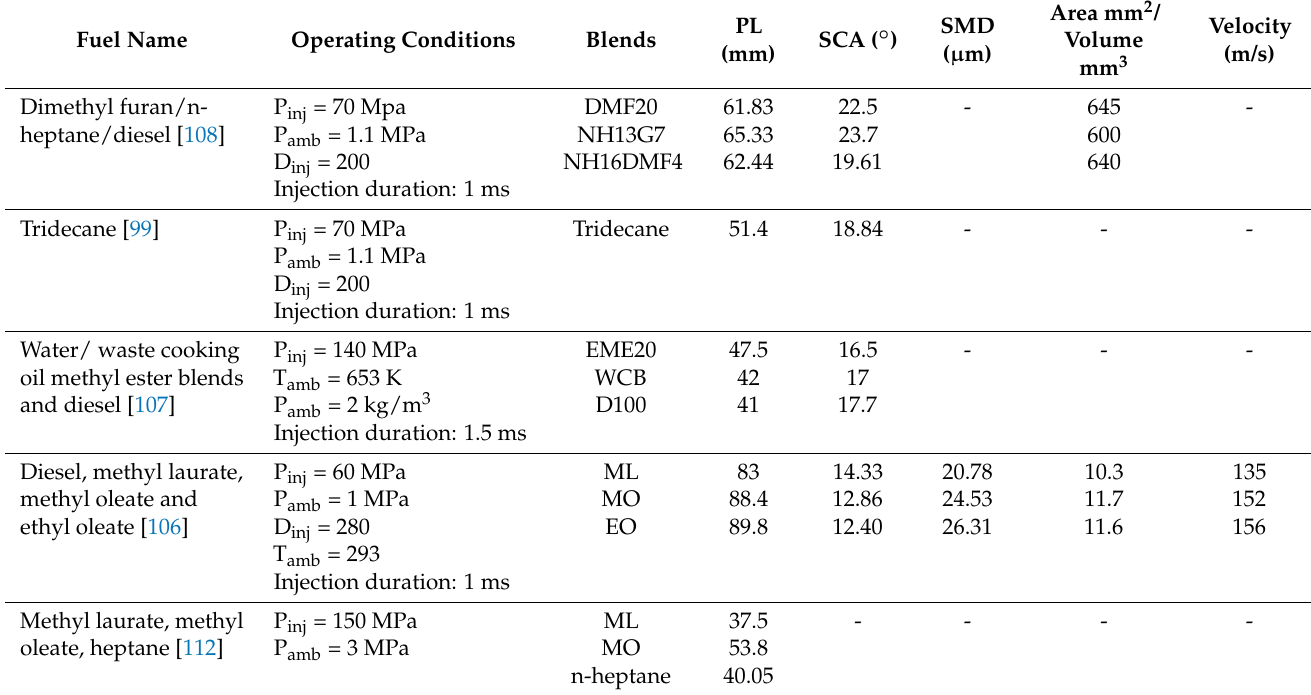
Table 8. Fuel spray characteristics of esters, aliphatic and aromatic compound